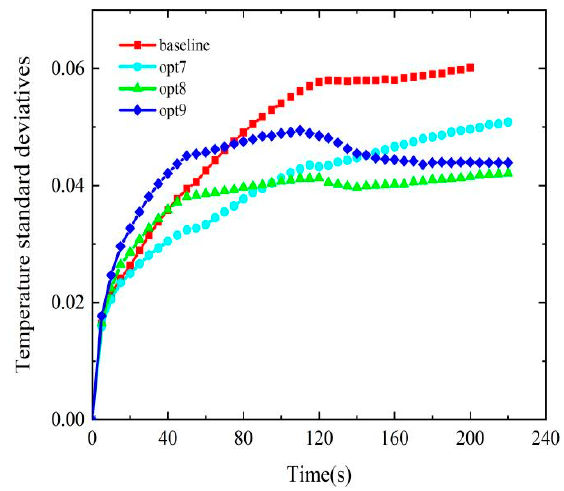
Figure 11. Temperature homogeneity inside the cylinder before and after optimization.